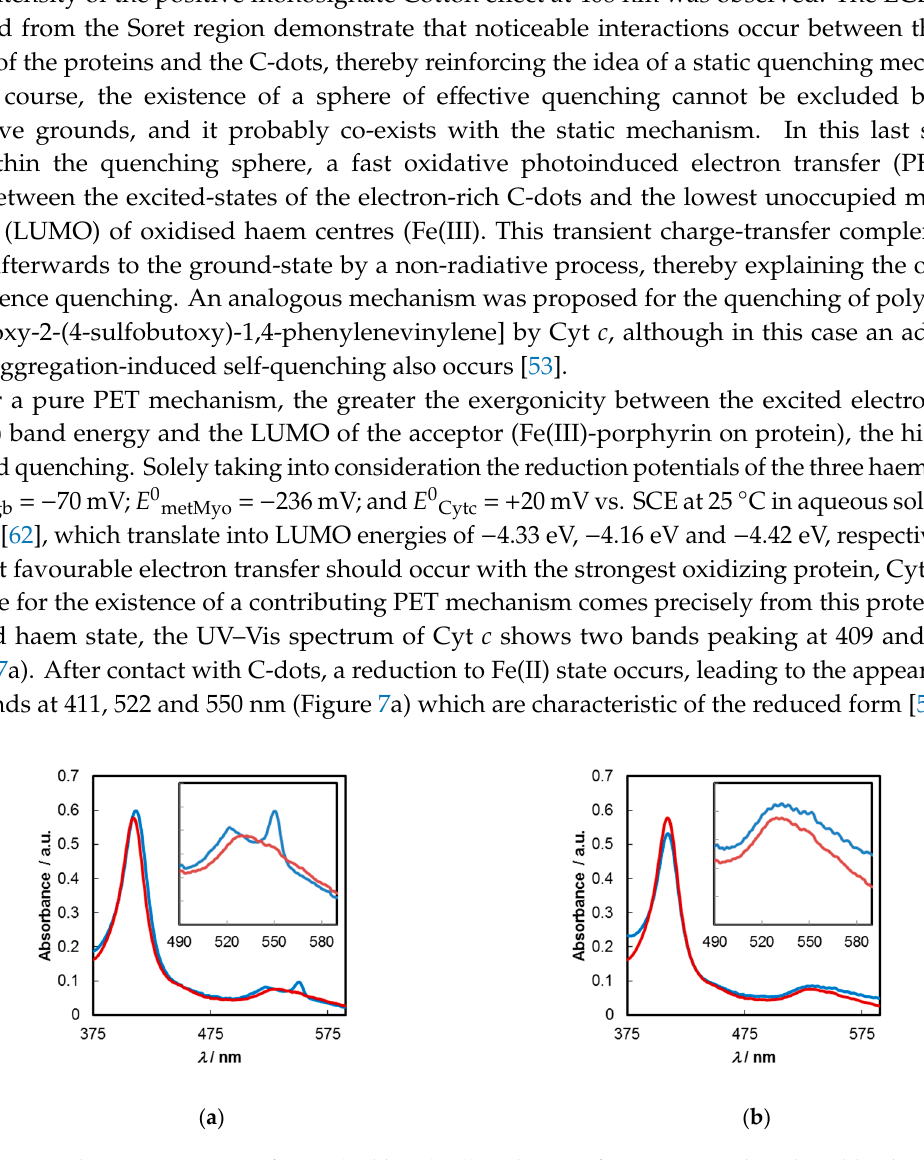
Figure 7. Absorption spectra of Cyt c (red line ( a ) and ( b )) and Cyt c after contact with C-dots (blue line ( a )) and C-dots/CA (blue line ( b )); [Cyt c ] = 6.6 µM, [C-dots] = 0.02 mg/mL and [C-dots/CA] = 0.005 mg/mL in buffered solutions at pH = 7.2.